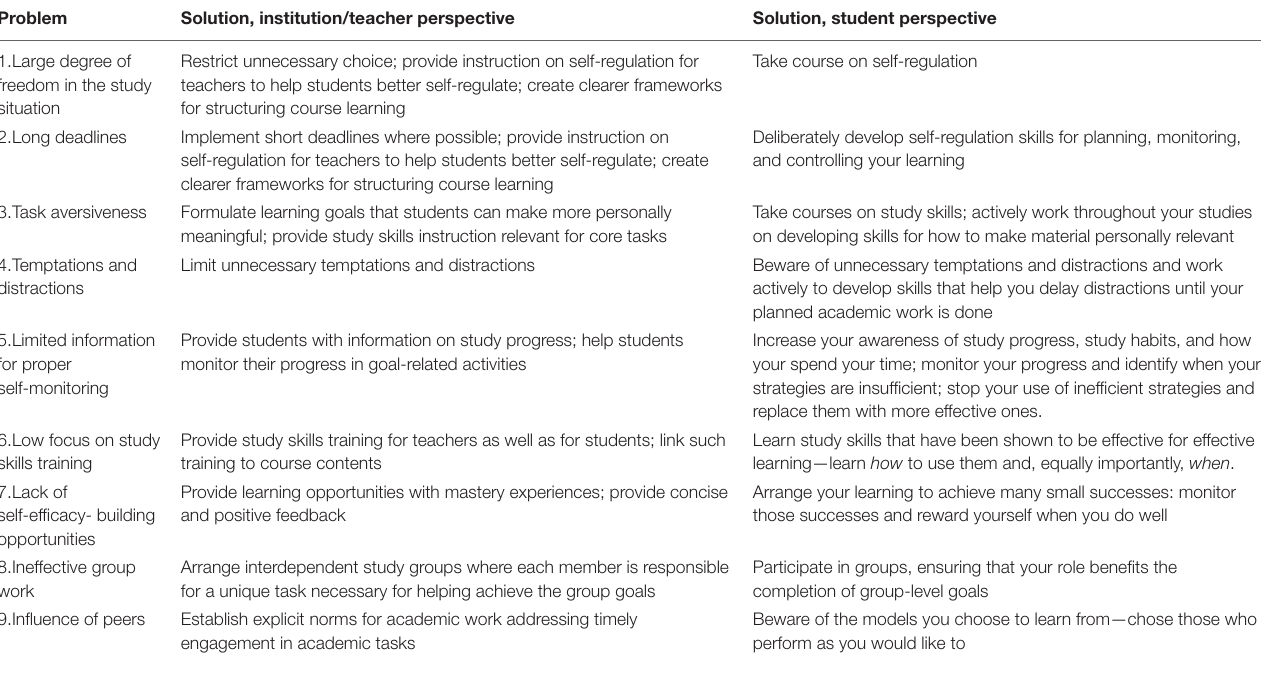
TABLE 2 | Recommended measures to reduce